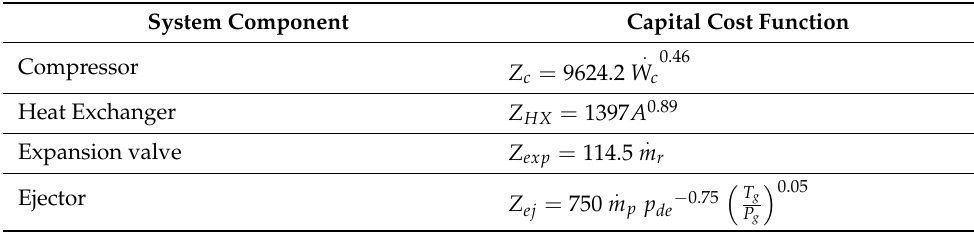
Table 4. Cost functions of various equipment [35,36].